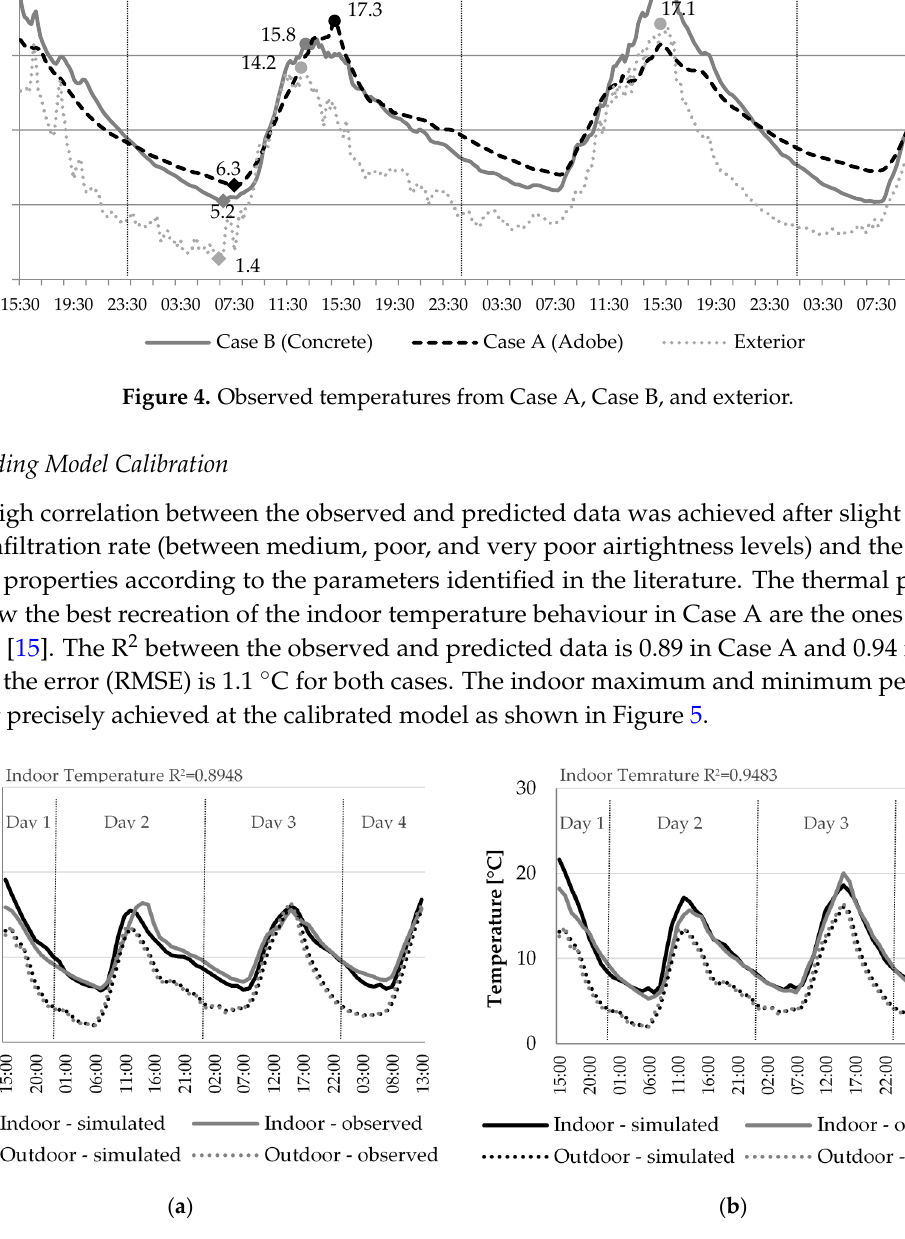
Figure 3. Observed temperature maximum, minimum, and interquartile range distribution.